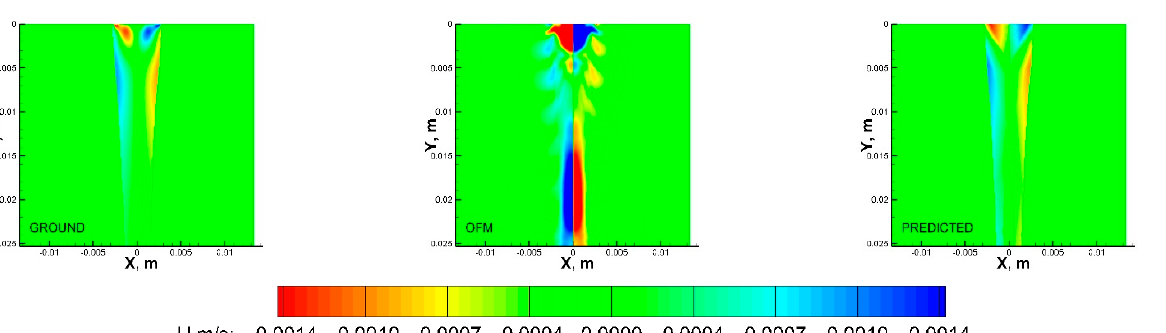
Table 2. Performance of regression models in terms of mean absolute error (mae) for two different loss functions: MSE, MAE. LASSO MLP CNN LSTM Validation with simulated test data MAE (m/s) 2 × 10 − 4 † Validation with in vitro experimental data MAE (m/s) 3 × 10 − 3 † * indicates p -value < 0.01, † indicates p -value < 0.05.